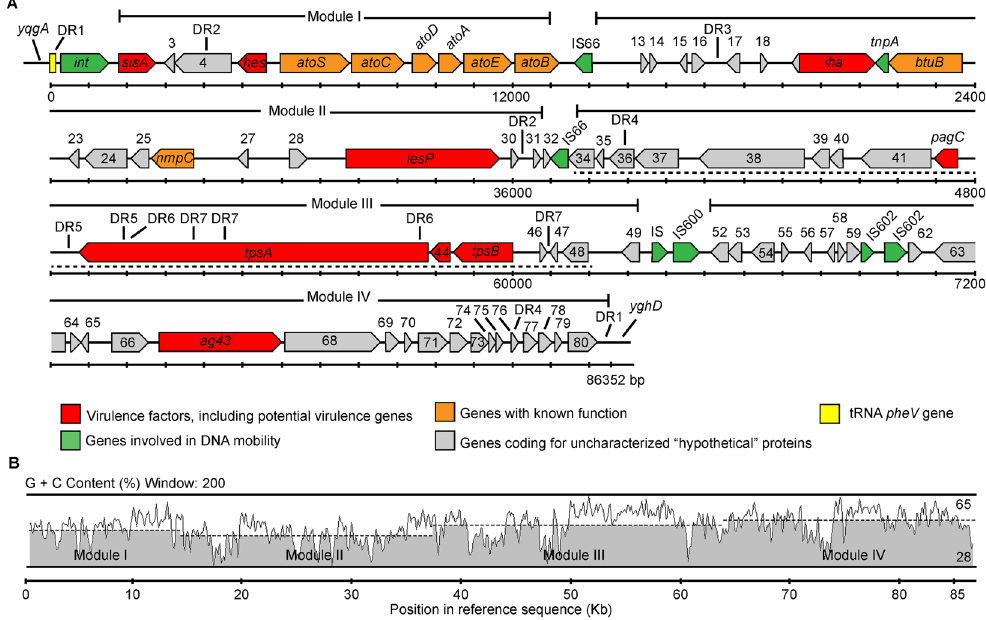
Figure 2. Genetic structure of the Locus of Adherence and Autoaggregation (LAA) pathogenicity island. ( A ) Predicted genes and direction of transcription are represented as block arrows. Open reading frames (ORFs) are color coded according to gene function, as indicated by legend at the bottom. Names of some genes are shown. Features of each ORF are listed in Supplementary Table 3. This DNA region is located between positions 385,984–472,336 bp in the contig #25 (GenBank accession: AFDQ01000026) of the draft genome of the B2F1 strain 56 . This pathogenicity island has a mosaic structure that is organized in modules flanked by IS elements and/or DR sequences. Dotted line, DNA region reported by Shen et al . 17 . ( B ) G + C content of each module: I (48.6%), II (43.8%), III (50.2%) and IV